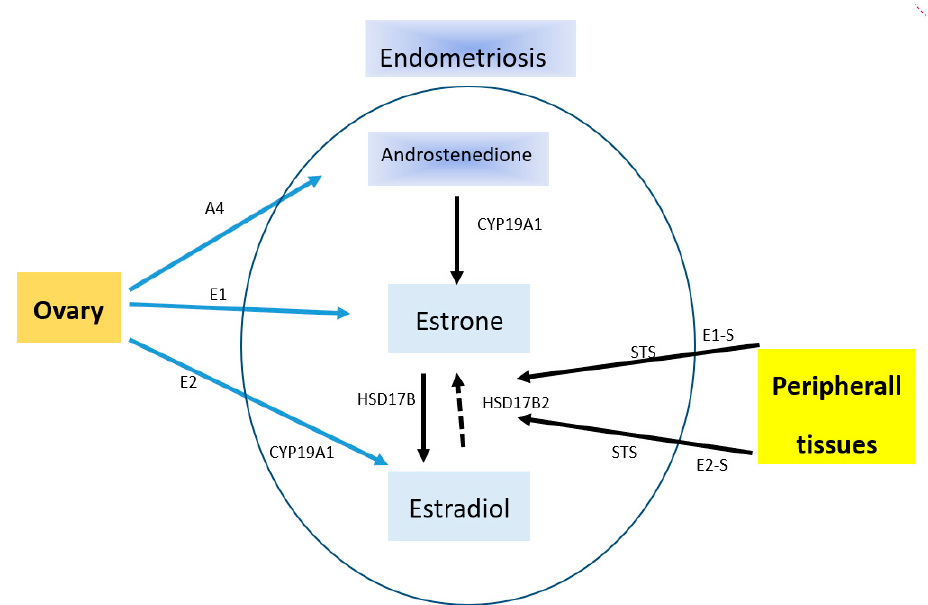
Figure 1. Source of estradiol in endometriosis. A4, androstenedione; CYP19A1, cytochrome P450 19A1 (aromatase); E1, estrone; E1-S, estrone sulfate; E2, estradiol; E2-S, estradiol sulfate; STS, steroid sulfatase; HSD17B, hydroxysteroid (17beta) dehydrogenase. Endometriosis is able to locally produce estrogens from E1-S and E2-S, which are circulating at high concentrations. This is due to the presence of steroid sulfatase activity. E2 can be inactivated through conversion to E1 by oxidative HSD17B activity. The major effects of estrogens are mediated by their classical nuclear receptors ESR 1 (Estrogen Receptor 1) and ESR2. CYP19A1 catalyzes the conversion of A4 to E1 as well as testosterone to E2.